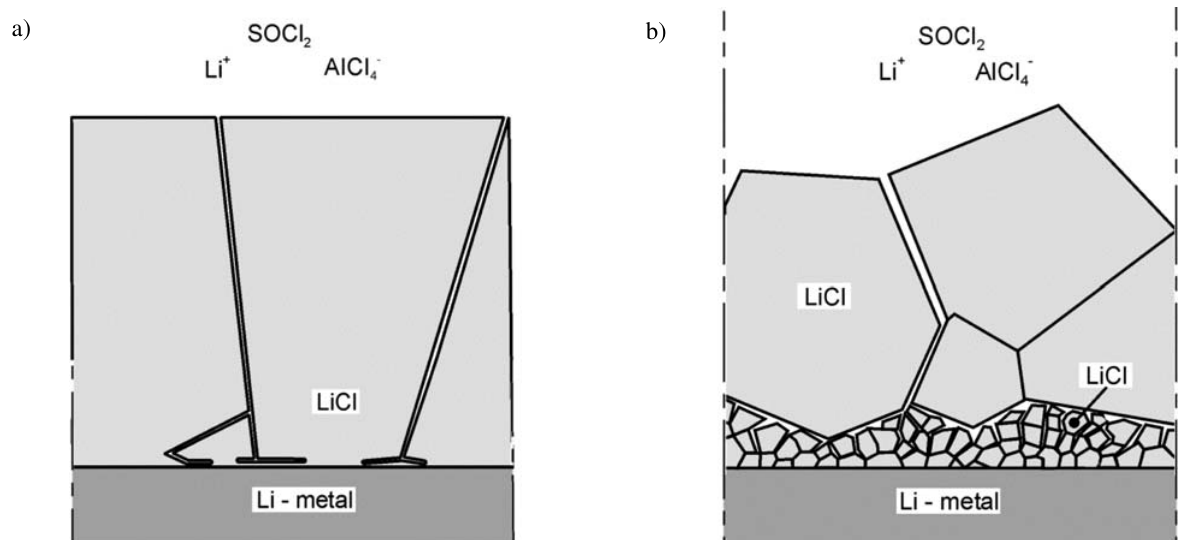
Figure 8. Sketches of possible structures of the LiCl passivating layer. The »simple crack« model (a) cannot explain the CPE type of impedance response. A very branched crack and tunnel system (b) seems necessary, and the small grains towards the Li-metal with bigger grains on top ref- lects the structures observed by SEM.